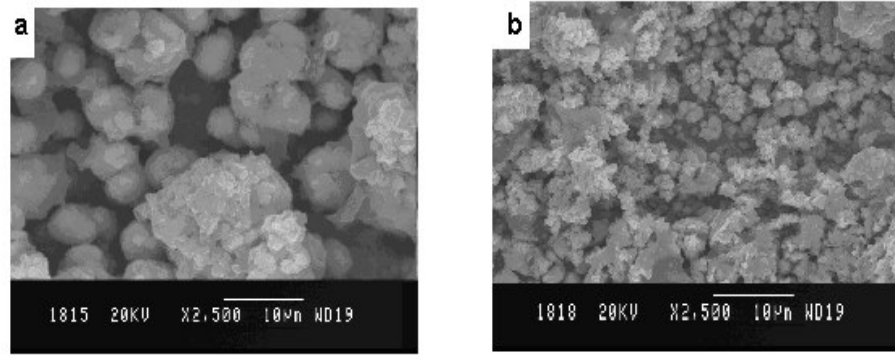
Figure 4. SEM images of (a) LiMn 2 O 4 (b) LiNd 0.3 Mn 1.7 O